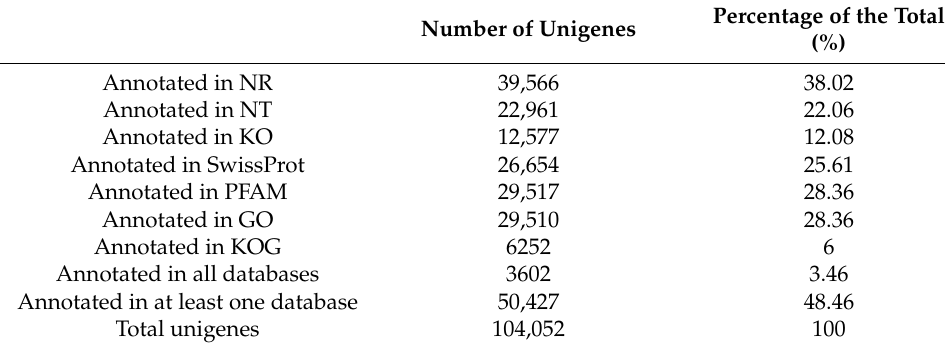
Table 1. Statistics of unigenes annotation in Michelia macclurei